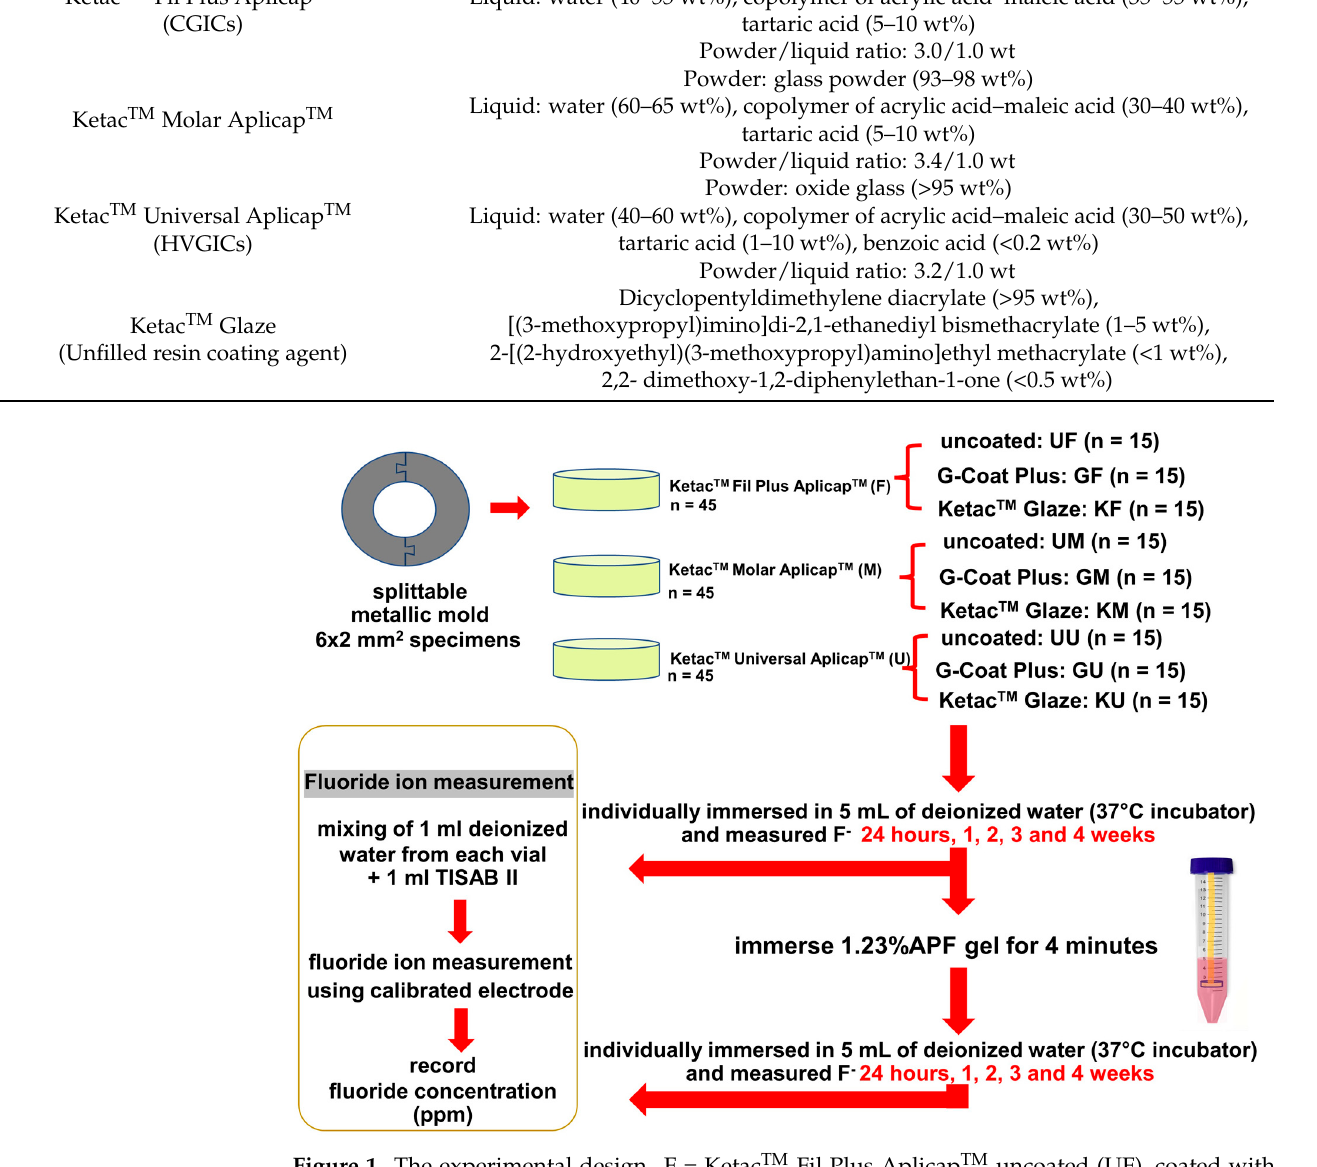
Table 1. Composition of the materials that were used in this study.